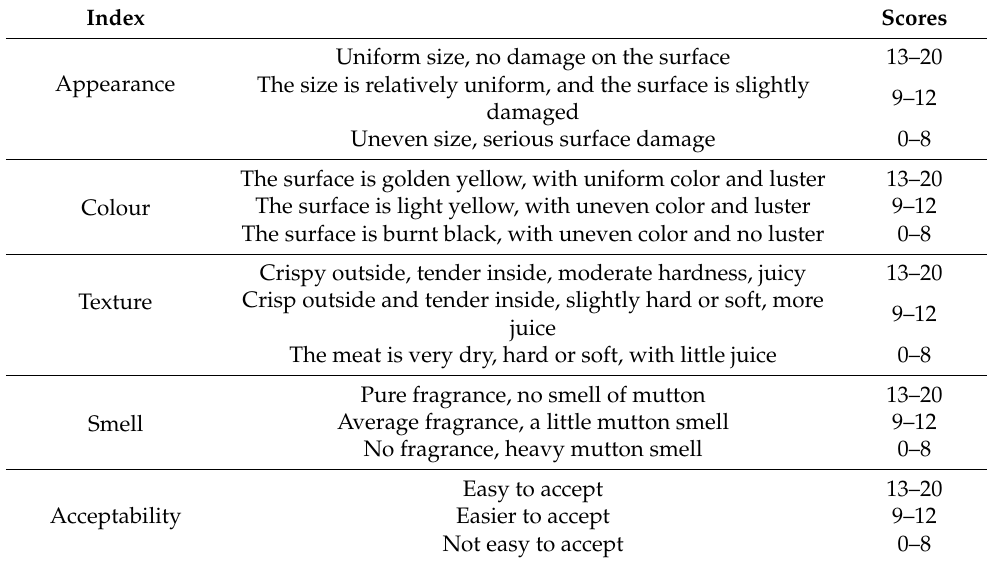
Table 7. Sensory evaluation and scoring criteria of BTS meat under different processing